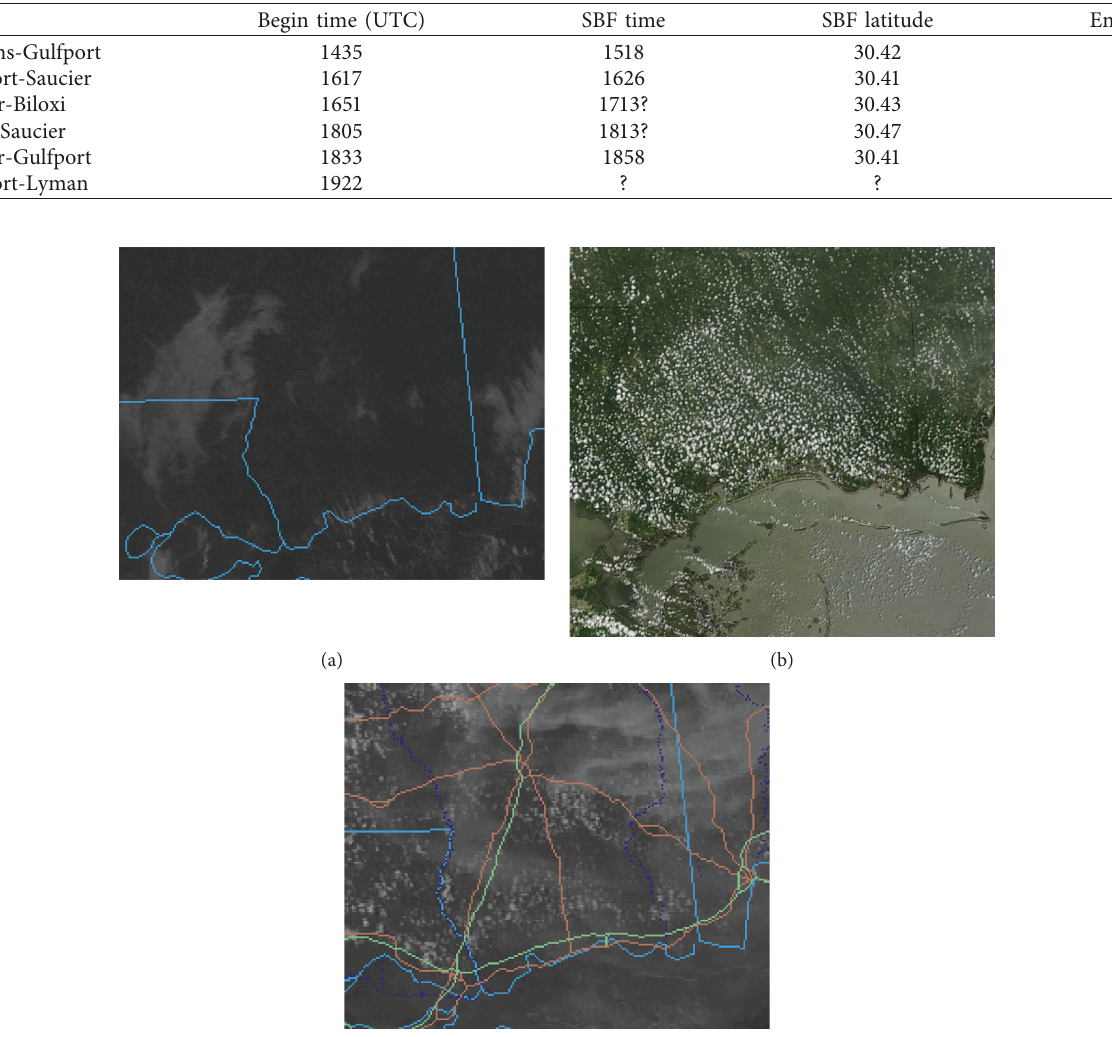
Table 1: North-south transects on 10 August 2015.